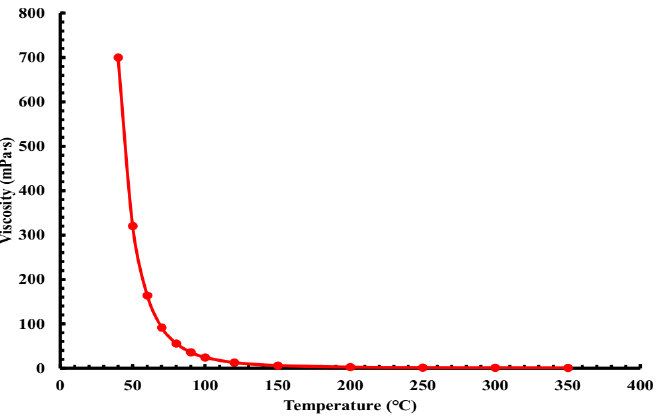
Figure 3. Oil viscosity vs.